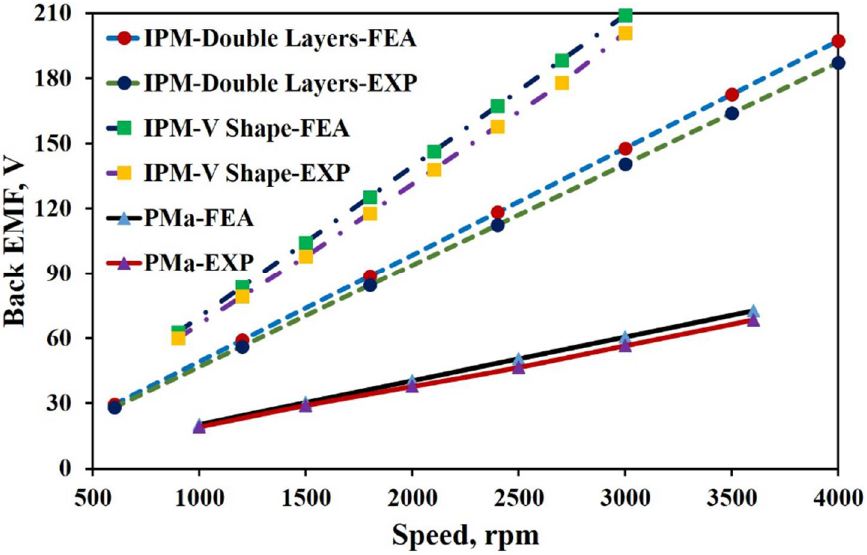
Figure 22. Comparison of back electromotive force (BEMF) of IPMSMs and PMa-SynRM.